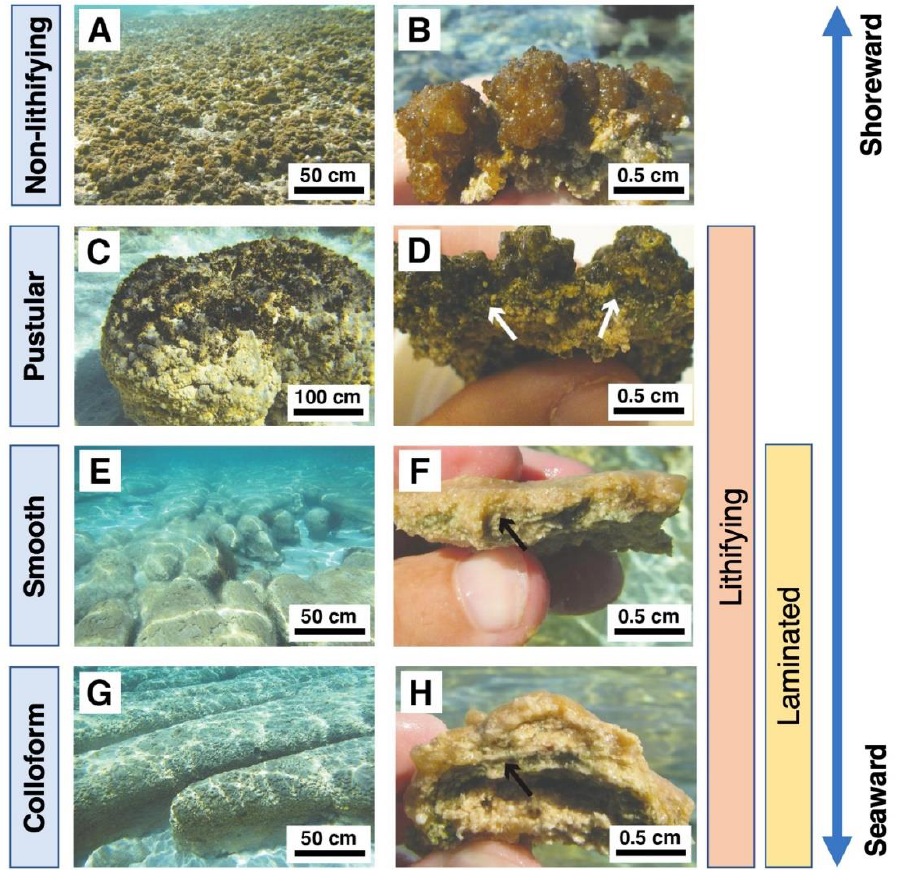
Figure 5. Modern mat types in Hamelin Pool, Shark Bay, Australia . Adapted from Babilonia, Conesa, Casaburi, Pereira, Louyakis, Reid, and Foster [47], under the license CC-BY 4.0. ( A ) Sheet of EPS-rich non-lithifying pustular mats in the intertidal zone. ( B ) Cross-section of EPS-rich non-lithifying pustular mat. ( C ) Pustular stromatolite-forming mat. ( D ) Cross-section of lithified pustular mat. ( E ) Lithified smooth mats ( F ) Cross-section of smooth mat showing laminations. ( G ) Lithified colloform mats have a bumpier surface texture and less fine laminations than smooth mats. ( H ) Cross-section of a colloform mat domal structure. Arrows in panels ( D , F , H ) indicate the cyanobacterial layers.